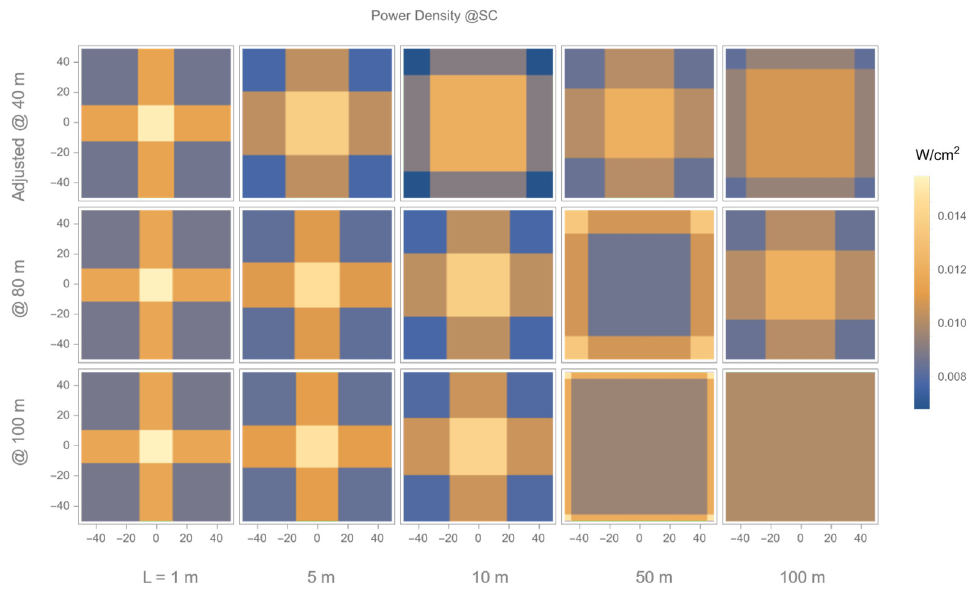
Figure 5. Power density of the incident beam at solar cell array (SC).